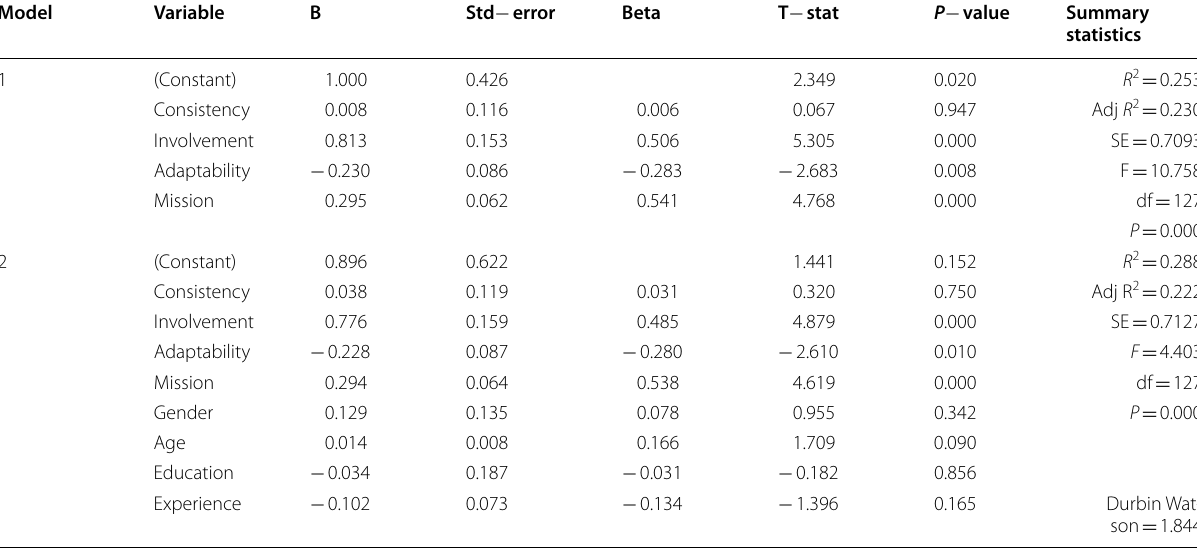
Table 8 Regression summary